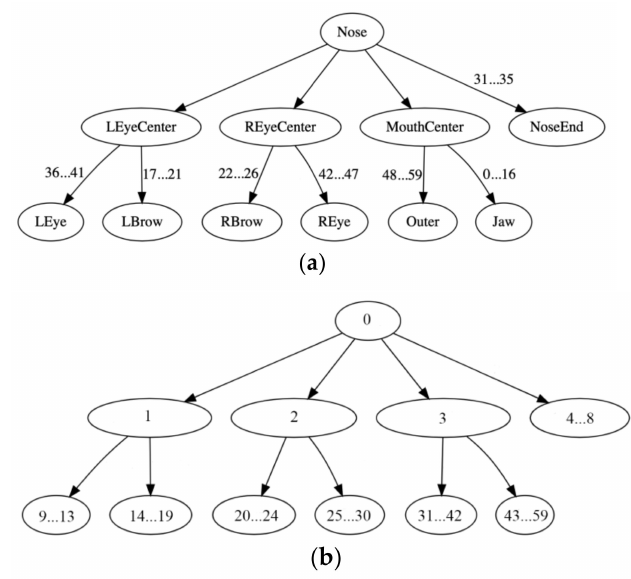
Figure 3. The considered tree structure representation of a human face. ( a ) The primary points ‘LEyeCenter’, ‘REyeCenter’ and ‘MouthCenter’ are computed from facial landmark points, as detailed in the text. All facial landmark points are labeled numerically using the labels (i.e., numbers) of Figure 2. ( b ) The above facial points are re-numbered sequentially. In all, there are 8 primary points (on the first tree level) and 51 secondary points (on the second tree